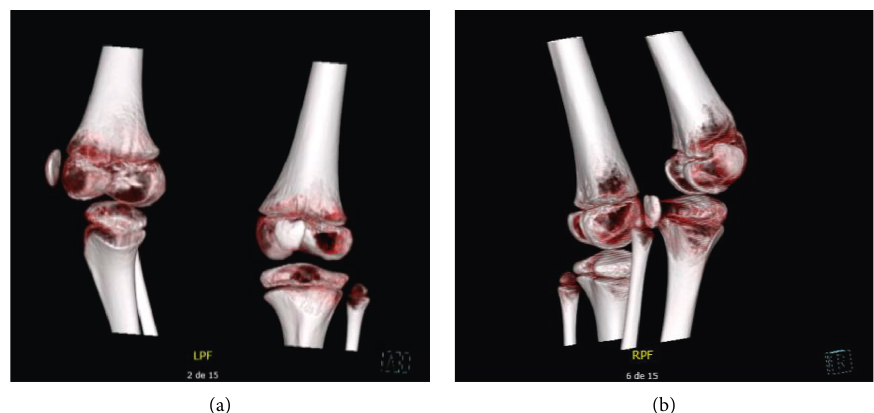
Figure 2: Patient 2: preoperative CTscan 3D reconstructions showing patella subluxation and femorotibial rotation (a) and normal state (b).